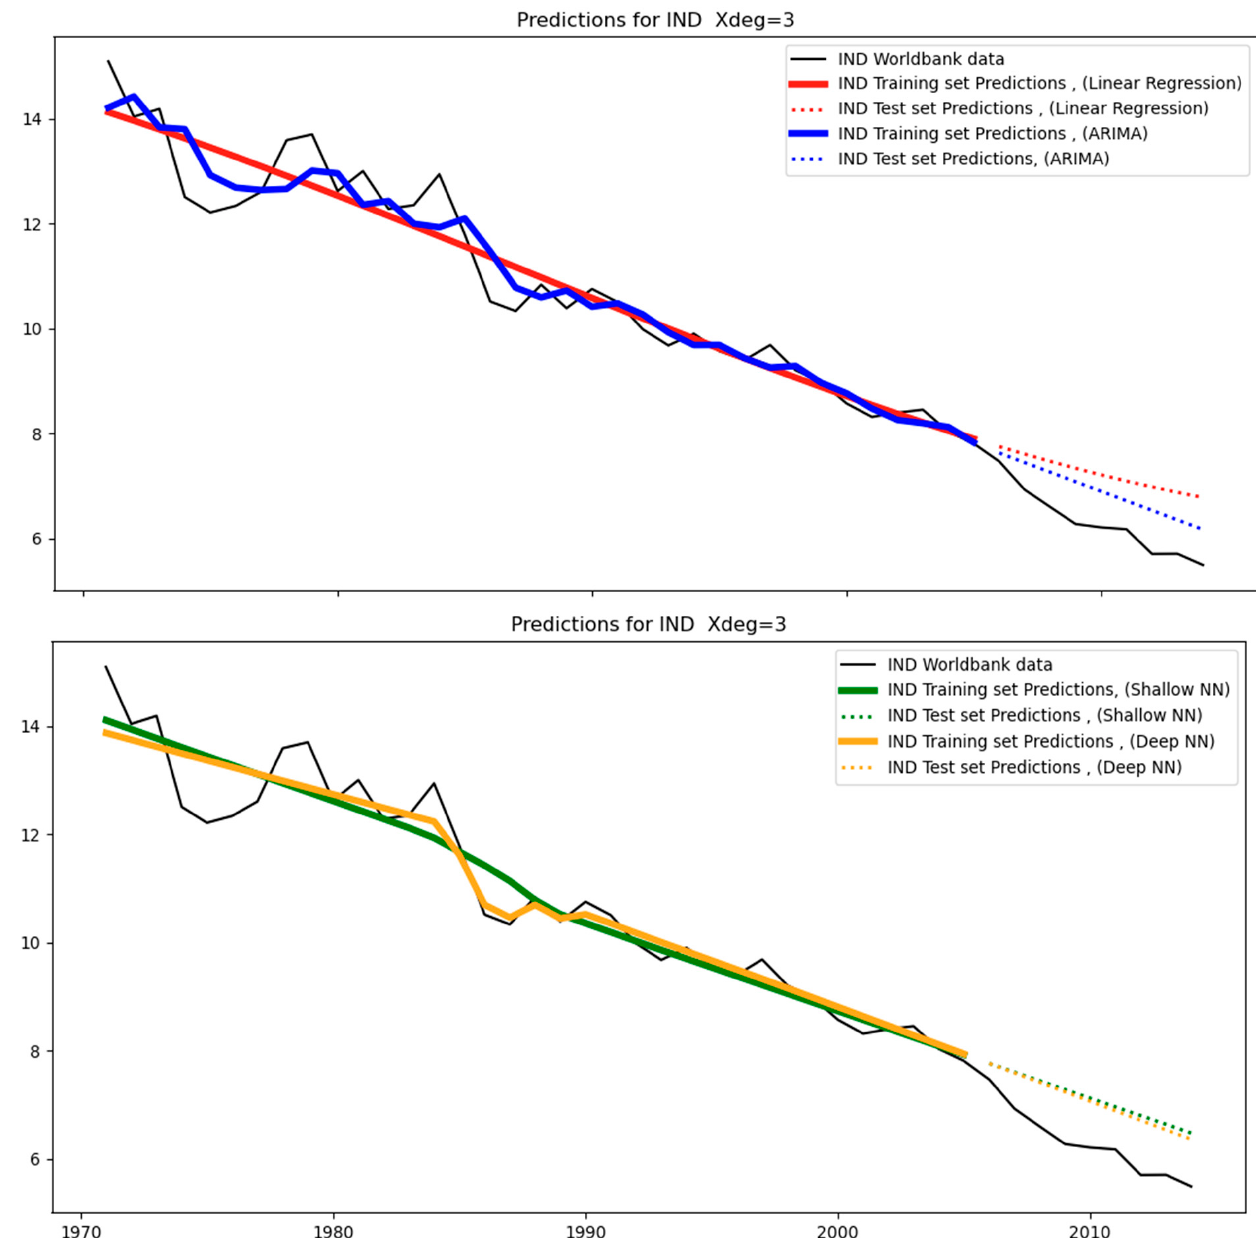
Figure 5. Predictions for India (IND), with a third-degree polynomial (Xdeg = 3), are shown for both the training set (periods 1971–2005) and the test set (periods 2006–2014), using linear regression (LR), ARIMA, shallow neural networks, and deep neural network models.